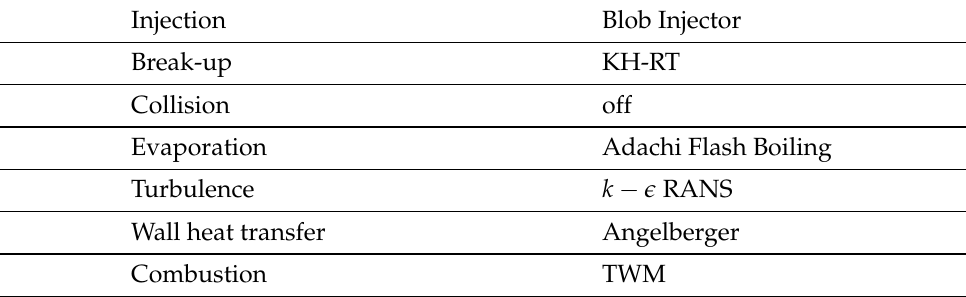
Table 2. CFD models